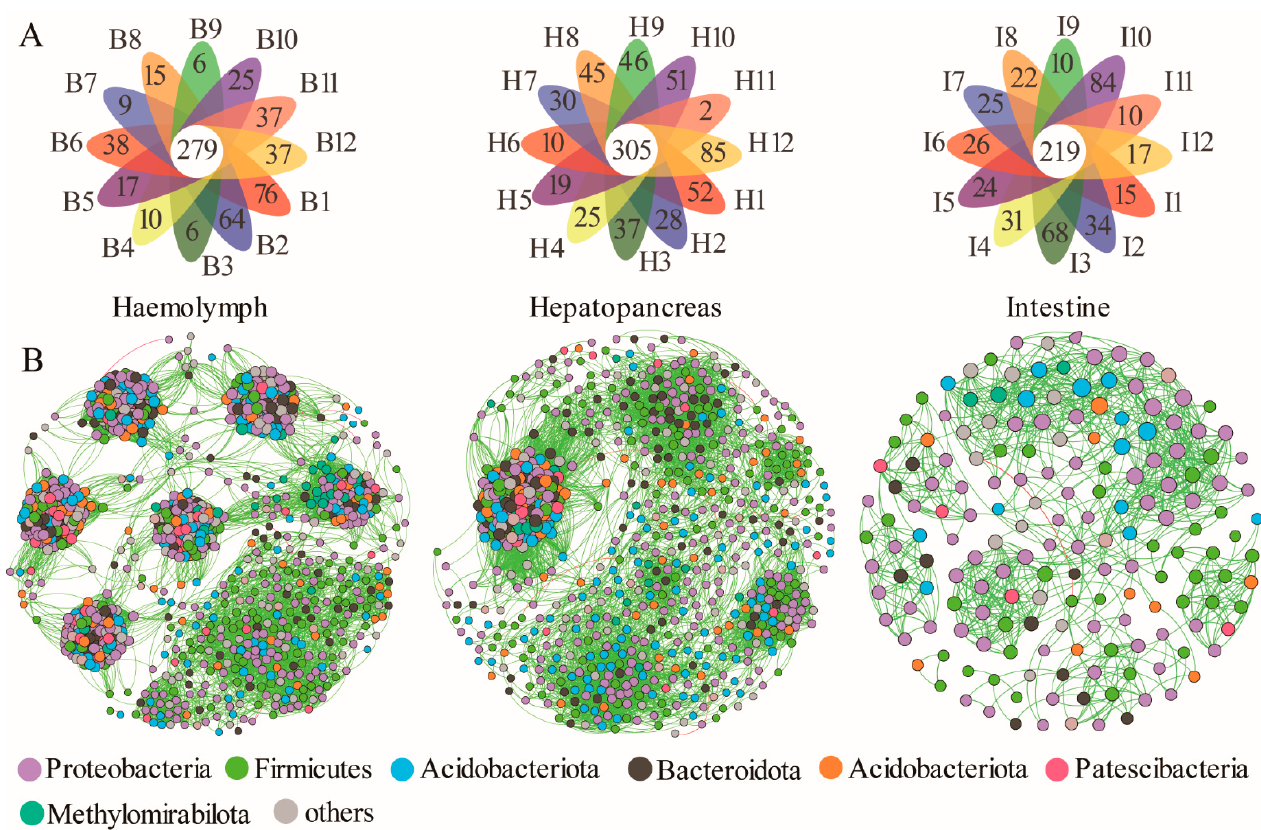
Figure 4. ( A ) The petalogram shows the number of genera that were shared at different sites of twelve crabs. ( B ) Network of co ‐ occurring bacterial OTUs across three sites. Only Spearman’s cor ‐ relation coe ffi cient (r > 0.7 or r < − 0.7 signi fi cant at p < 0.05) is shown. The nodes are colored according to phyla. Green edges represent positive correlations and red edges represent negative correlations. Node size is proportional to the betweenness centrality of each OTU, and edge thickness is propor ‐ tional to the weight of each correlation.